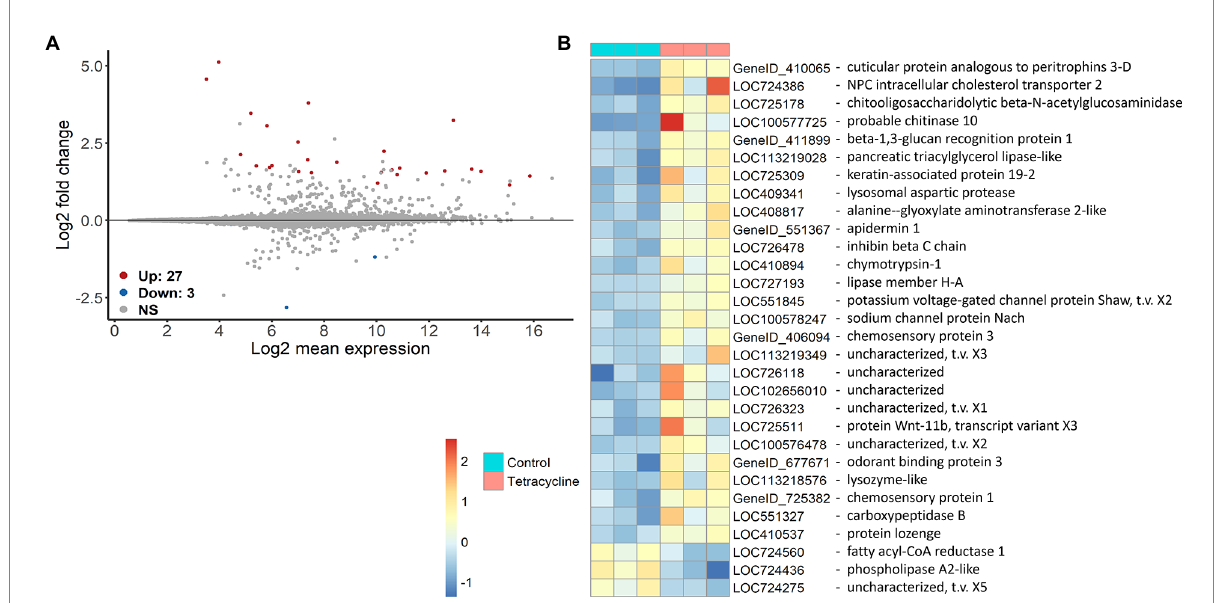
FIGURE 6 Differential gene expression of genes in naïve bees that received tetracycline-exposed in comparison to individuals that received control microbiomes. MA plots show the differential expression of the tetracycline-gut against the control-gut treatment ( n = 3 (one bee per cage for both treatments respectively)) (A) . The x axis shows the average expression over the mean of normalized counts, and the y axis shows the gene-wise dispersion estimate’s shrunken log2 fold change. Red and blue points indicate significant up- or downregulation (FDR ≤ 0.05 determined by DESeq2) of individual genes. Heatmap on rlog() transformed data shows the expression difference of each significantly different gene in a specific sample from the gene’s average across all samples. In addition the gene descriptions are shown (B)